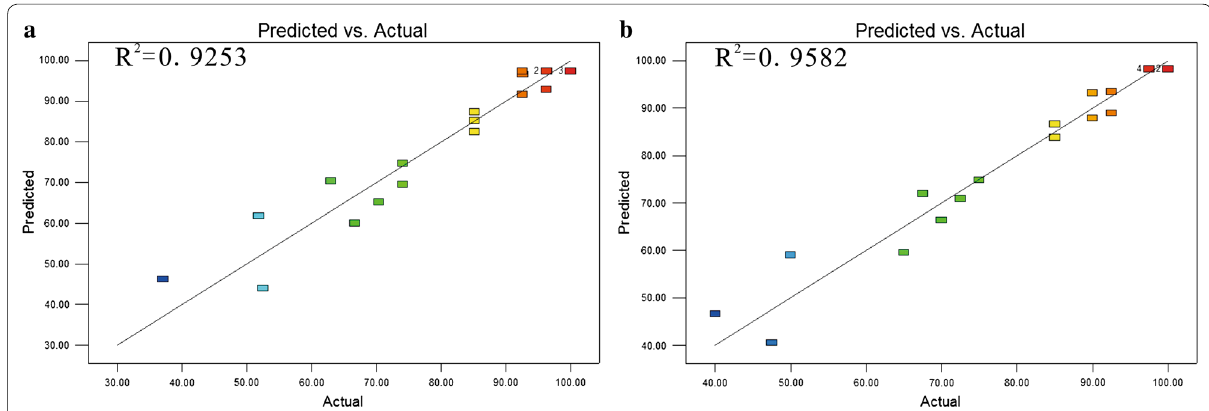
Fig. 2 The determination coefficients (R2) between predicted and experimental values: a R2 of mode Y1, b R2 of mode Y2